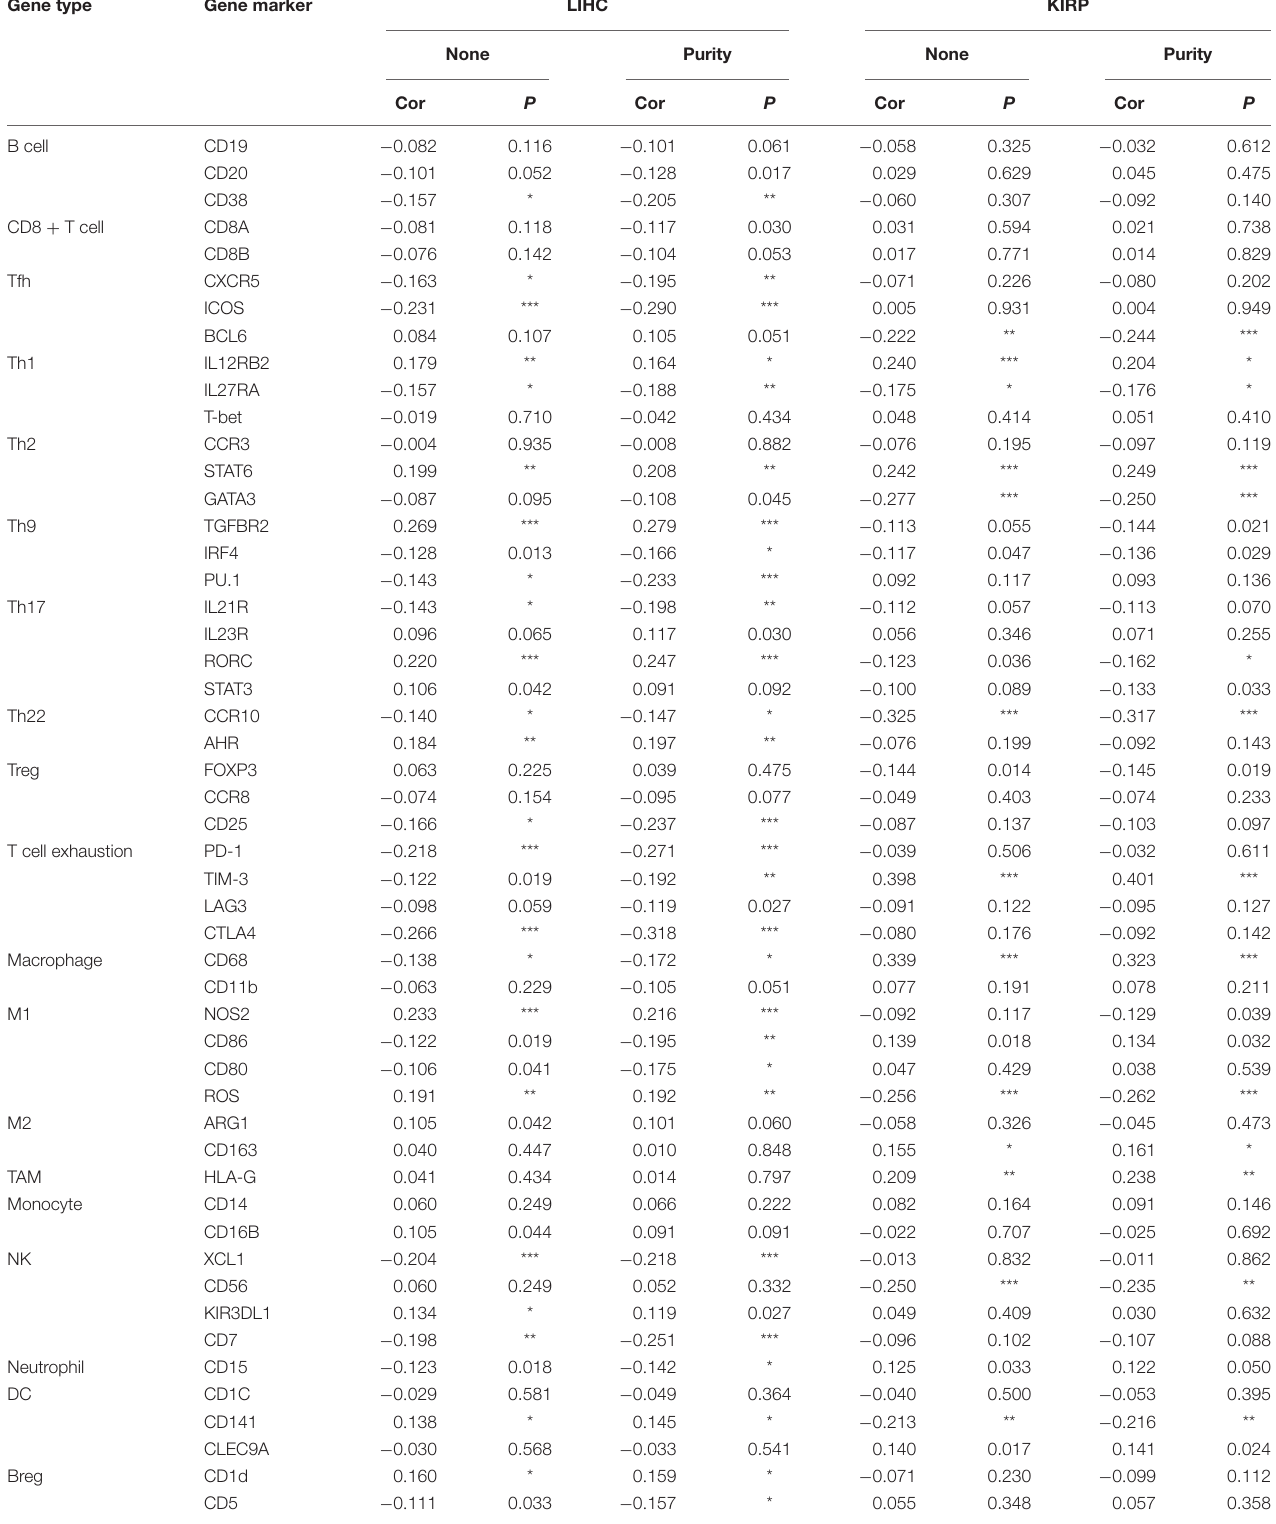
TABLE 2 | Correlations between ACE2 and gene markers of immune cells in LIHC and KIPR. Gene type Gene